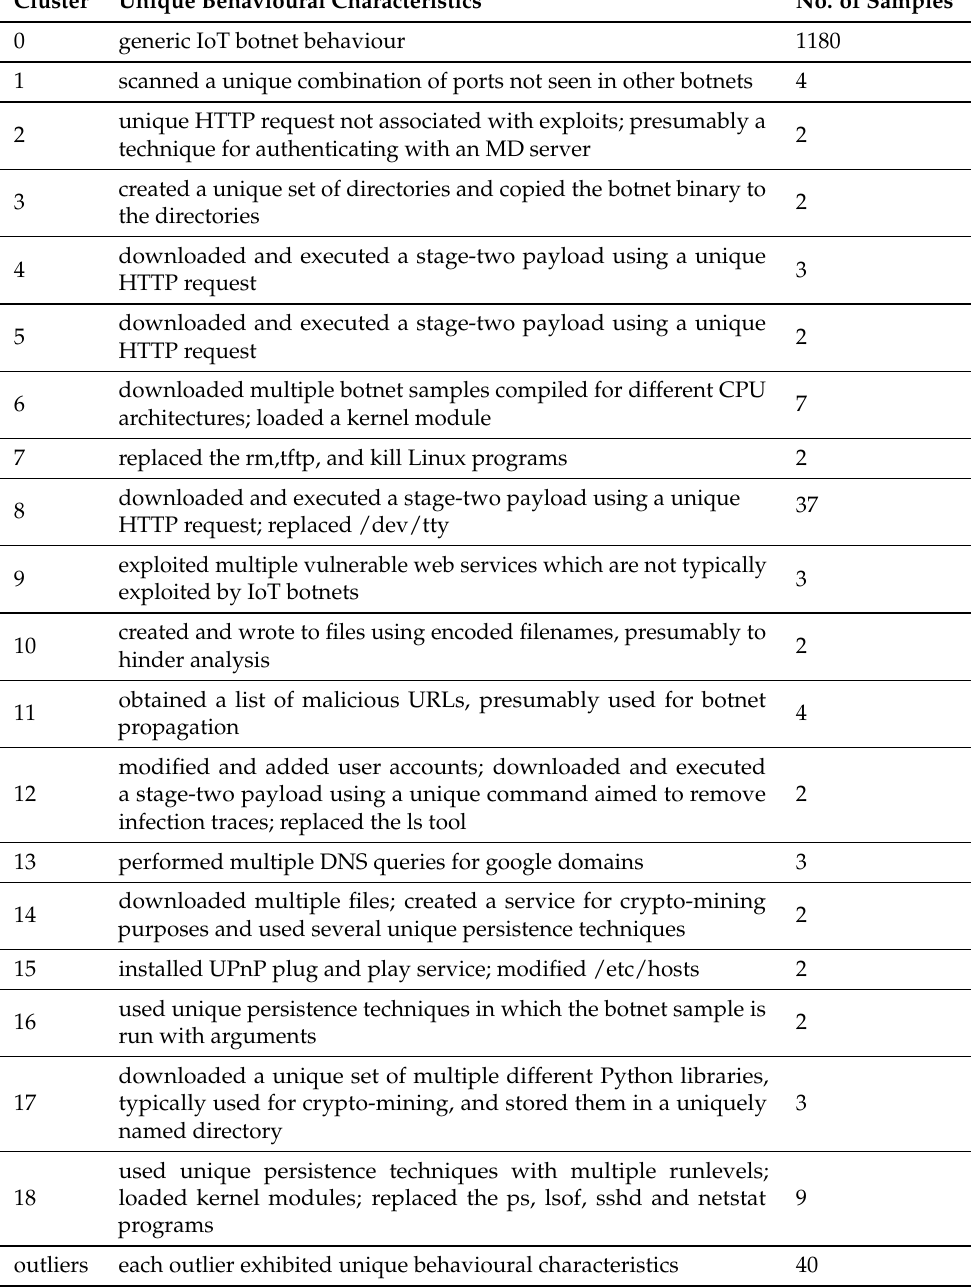
Table 6. Unique behavioural characteristics and number of samples per